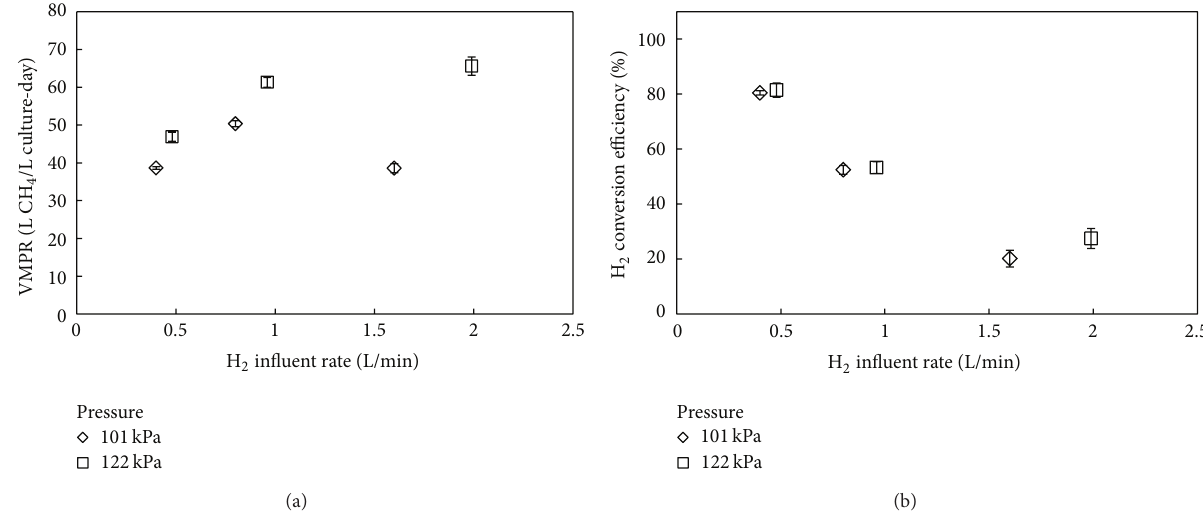
Figure 3: Bioreactor performance for Experiment 2. Volumetric methane production rates (a) and hydrogen conversion efficiencies (b) for bioreactor runs in which the hydrogen influent rate was varied. Data were gathered during two different headspace pressures in the bioreactor (atmospheric pressure (101kPa) and 122 kPa). The error bars represent the observed variance between runs for each bioreactor condition. Table 3: Performance comparison between studies for M. thermautotrophicus cultures and reactor microbiomes that produce methane. Studies \ parameters and